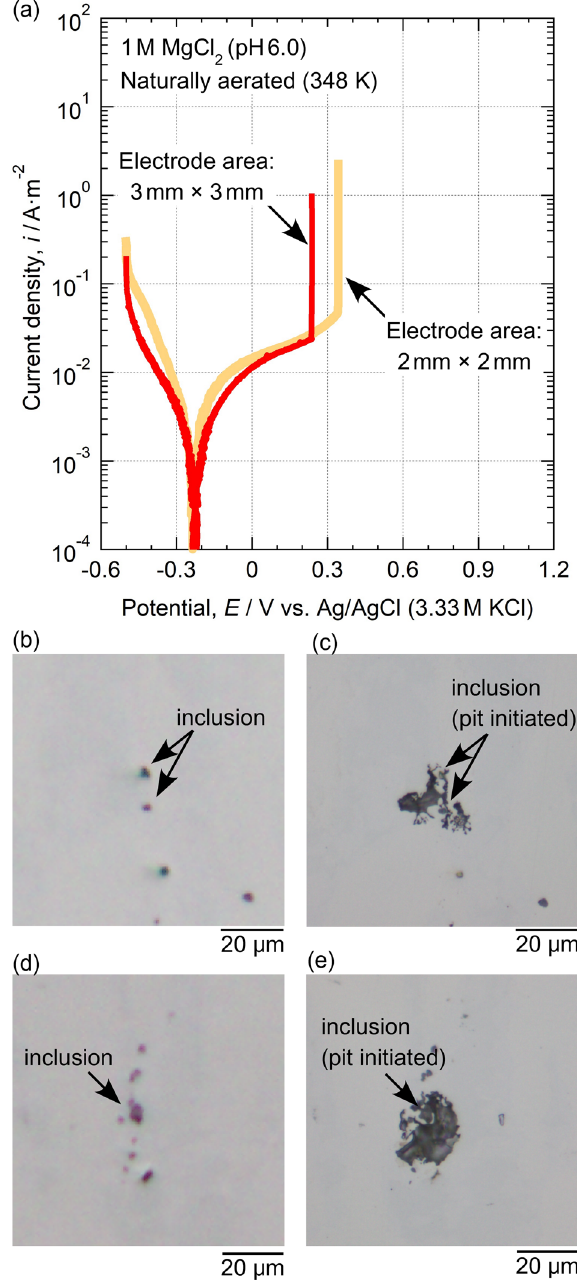
Fig. 9 Polarization behavior of 2 × 2 mm and 3 × 3 mm electrodes. a Effect of the electrode area size on the polarization behavior of the aged specimen in naturally aerated 1 M MgCl 2 at pH 6.0 (348 K). b – e Optical micrographs of the pitting corrosion initiation sites b , d before and c , e after polarization of b , c 2 × 2 mm and d , e 3 × 3 mm electrodes.